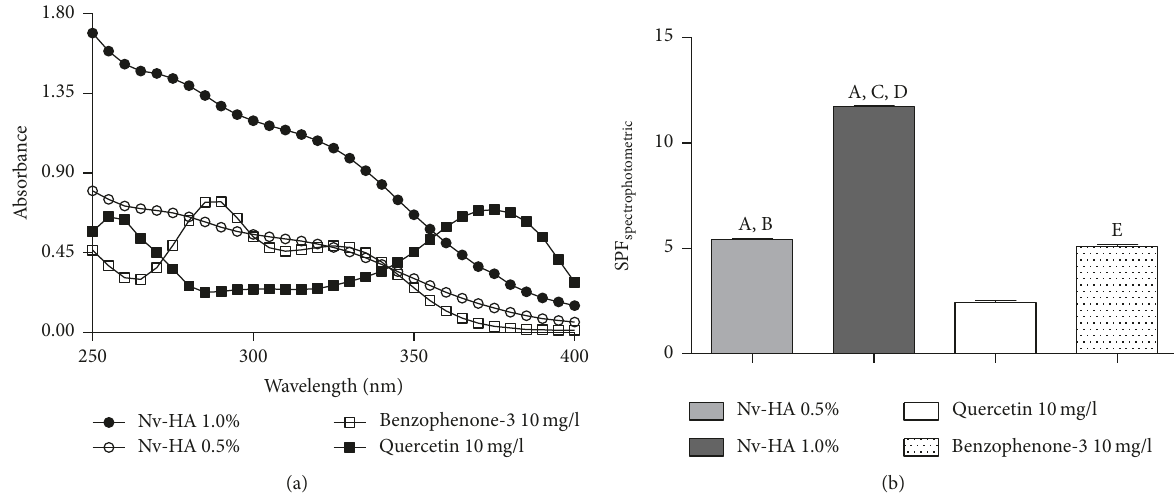
Figure 1: Spectrophotometric absorption spectra (a) and determination of the Sun Protection Factor (SPF) spectrophotometric (b) of NV-HA and standards (quercetin and benzophenone-3). Results are expressed as mean ± SD ( 𝑛 = 3 ), where A (𝑝 < 0.05 , Nv-HA 1.0% versus quercetin 10mg/L), B (𝑝 < 0.05 , Nv-HA 0.5% versus quercetin 10mg/L), C (𝑝 < 0.05 , Nv-HA 1.0% versus benzophenone-3 10mg/L), D (𝑝 < 0.05 , Nv-HA 1.0% versus Nv-HA 0.5%), and E (𝑝 < 0.001 , benzophenone-3 10mg/L versus quercetin 10mg/L), according to one-way ANOVA followed by Tukey’s test.